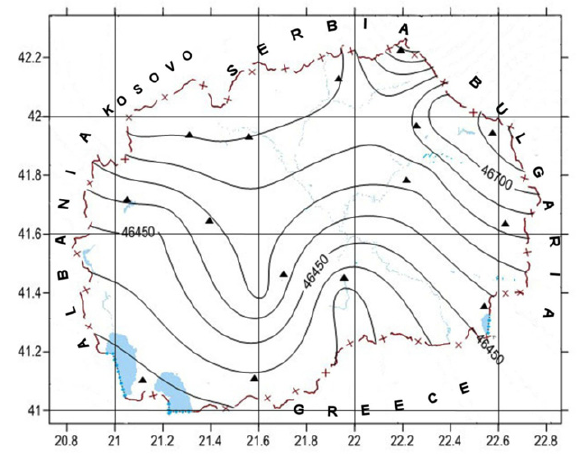
Figure 4. Map of total field vector F for the 2010.0 epoch.